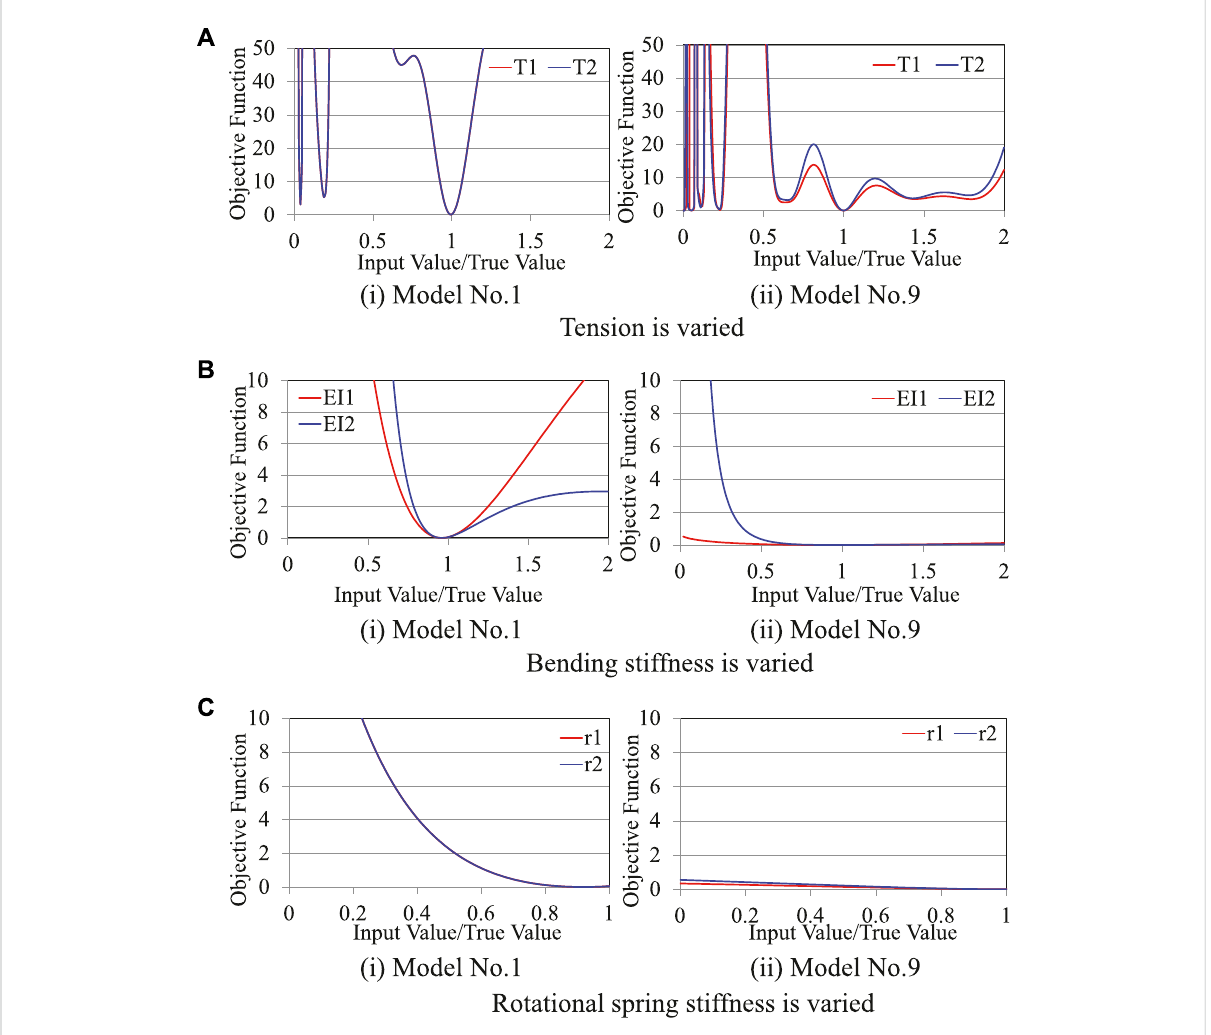
FIGURE 5 Sensitivity of tension, bending stiffness, and rotational stiffness to objective function for model No.1 (left) and model No. 9 (right). (A) Tension is varied. (B) Bending stiffness is varied. (C) Rotational spring stiffness is varied.